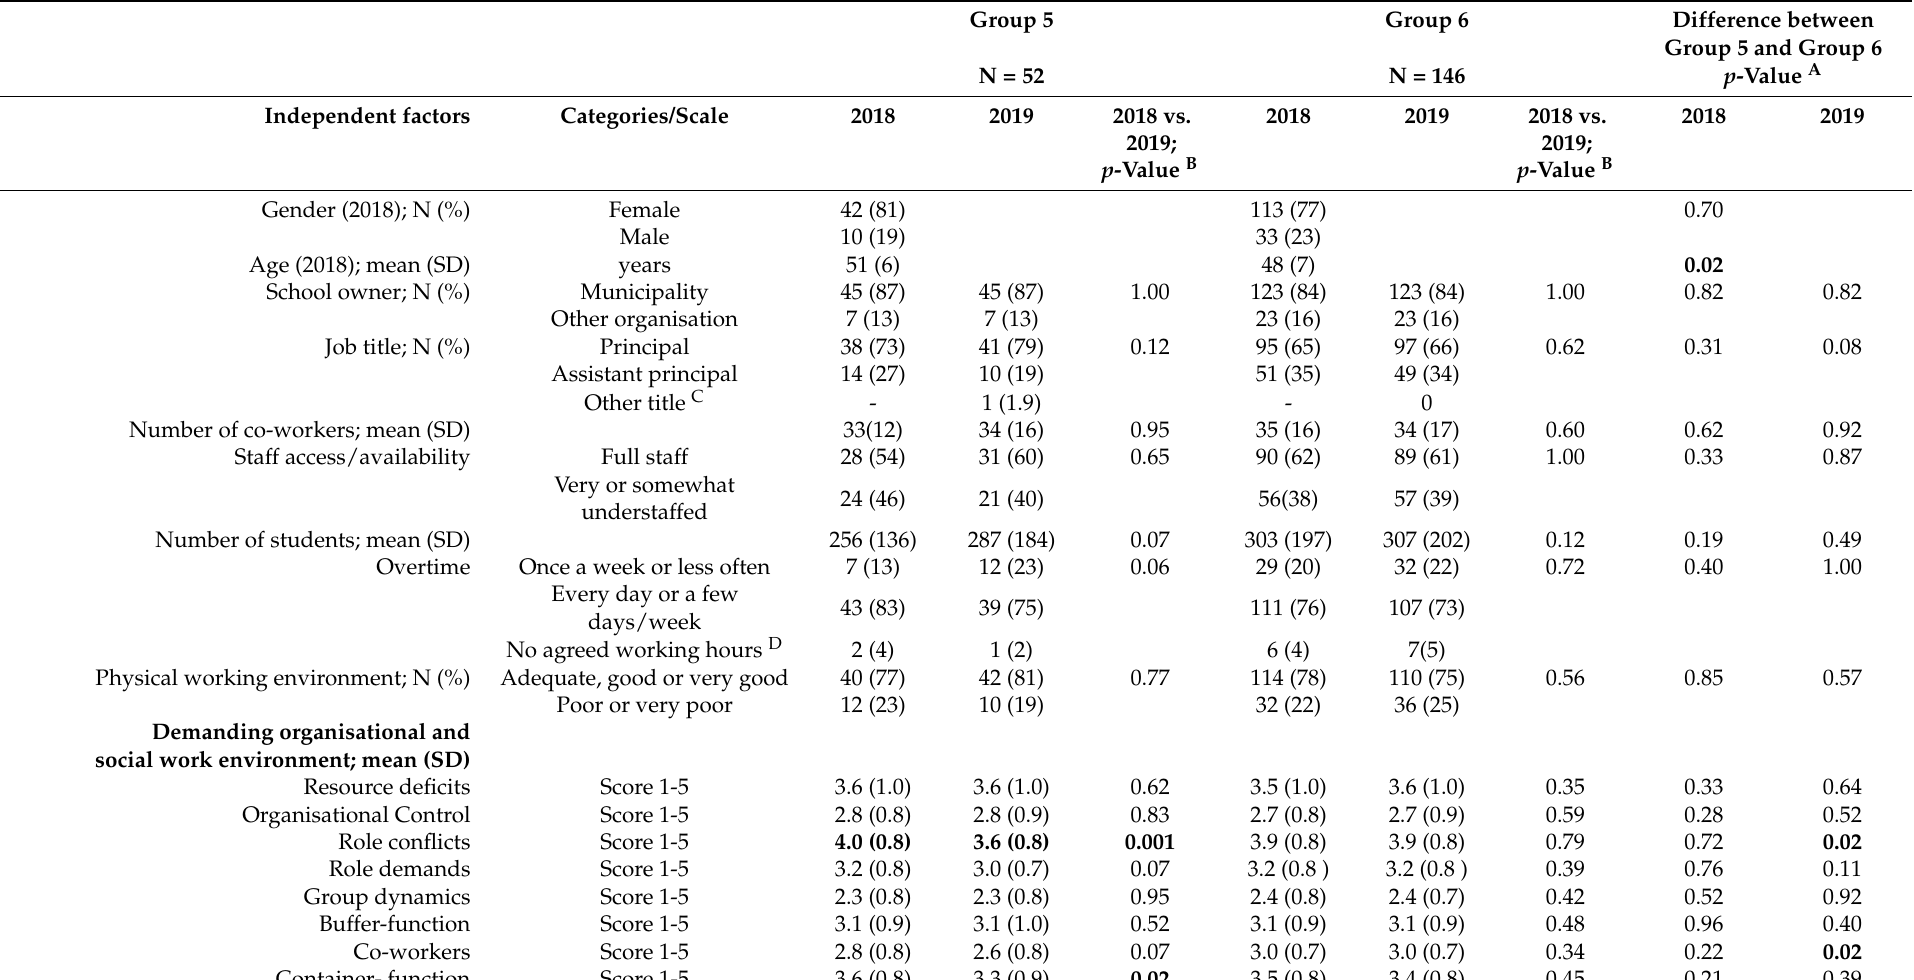
Table 4. Change of reported exposures in the year 2018 vs. in the year 2019, within and between Group 5 (Leave/No change/Stay) and Group 6 (Leave/No change/Leave) (Figure 1). Group